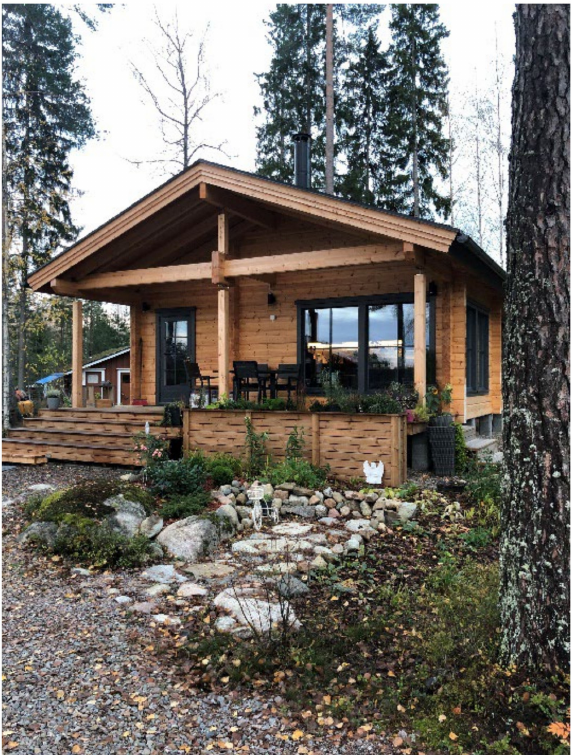
Figure 5. A modern single-family home with log construction in Finland. (Photo courtesy of Lotta Häkkänen).